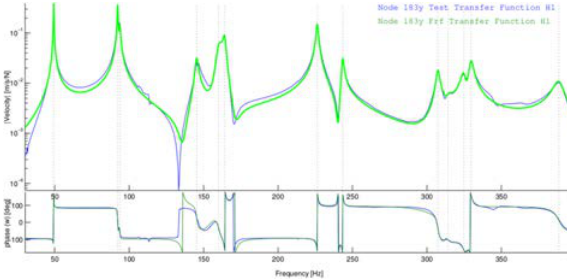
Figure 8: FRF(blue) and fitting curve (green) of composite model at node 183y [10].